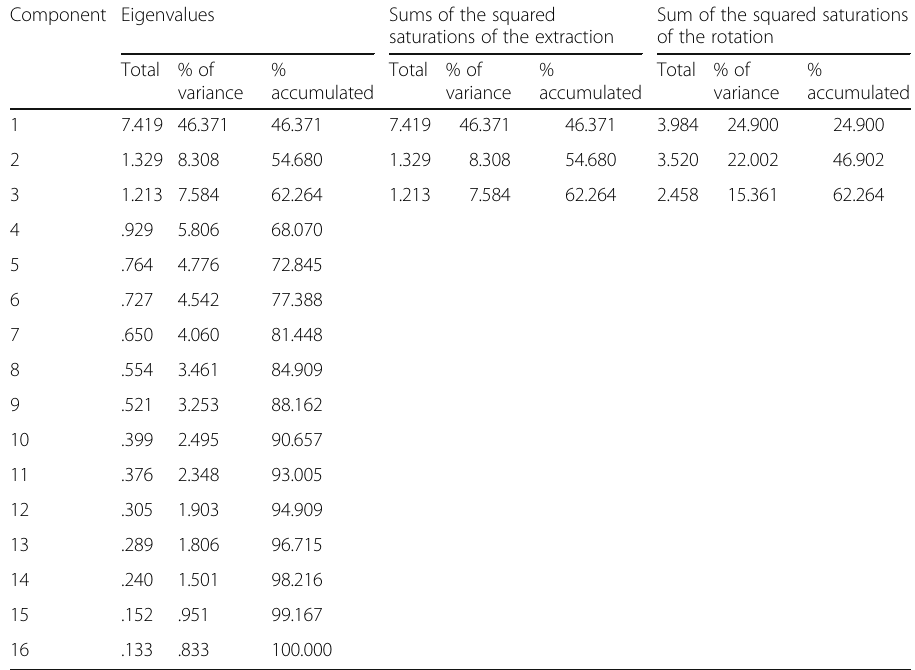
Table 3 Total variance explained by the principal component analysis Component Eigenvalues